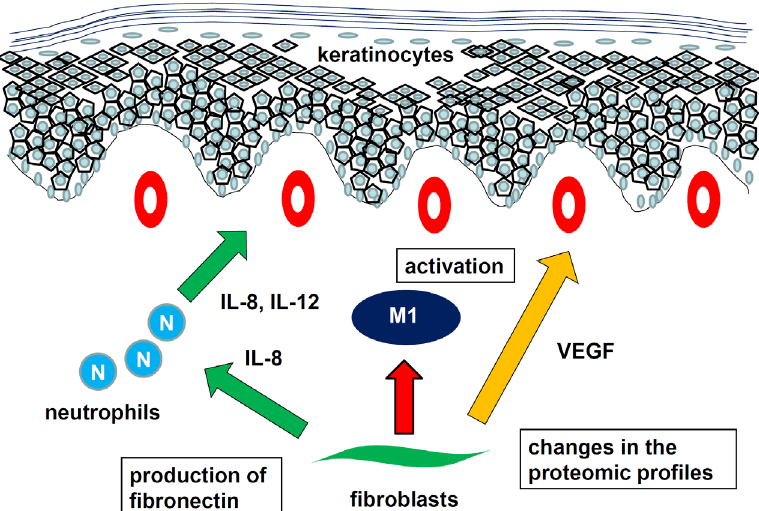
Figure 5. Role of fibroblasts in psoriasis. Fibroblast express IL-8, inducing chemotaxis and activation of neutrophils. Activation of M1 macrophages, production of fibronectin, and changes in the proteomic profiles contribute to development of